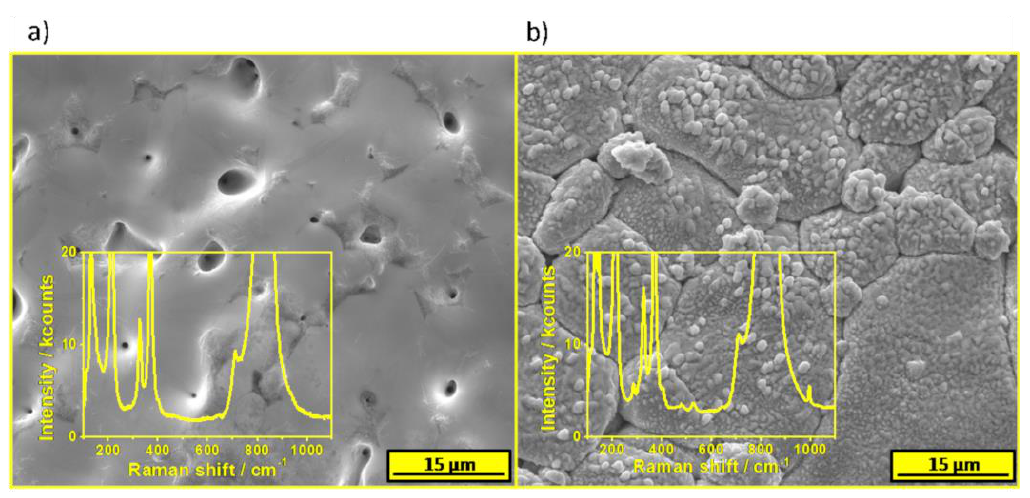
Figure 5. The SEM images and Raman spectra of a BiVO 4 target after pulsed laser deposition. ( a ) The area exposed to the laser pulses and ( b ) the area not subjected to the ablation.